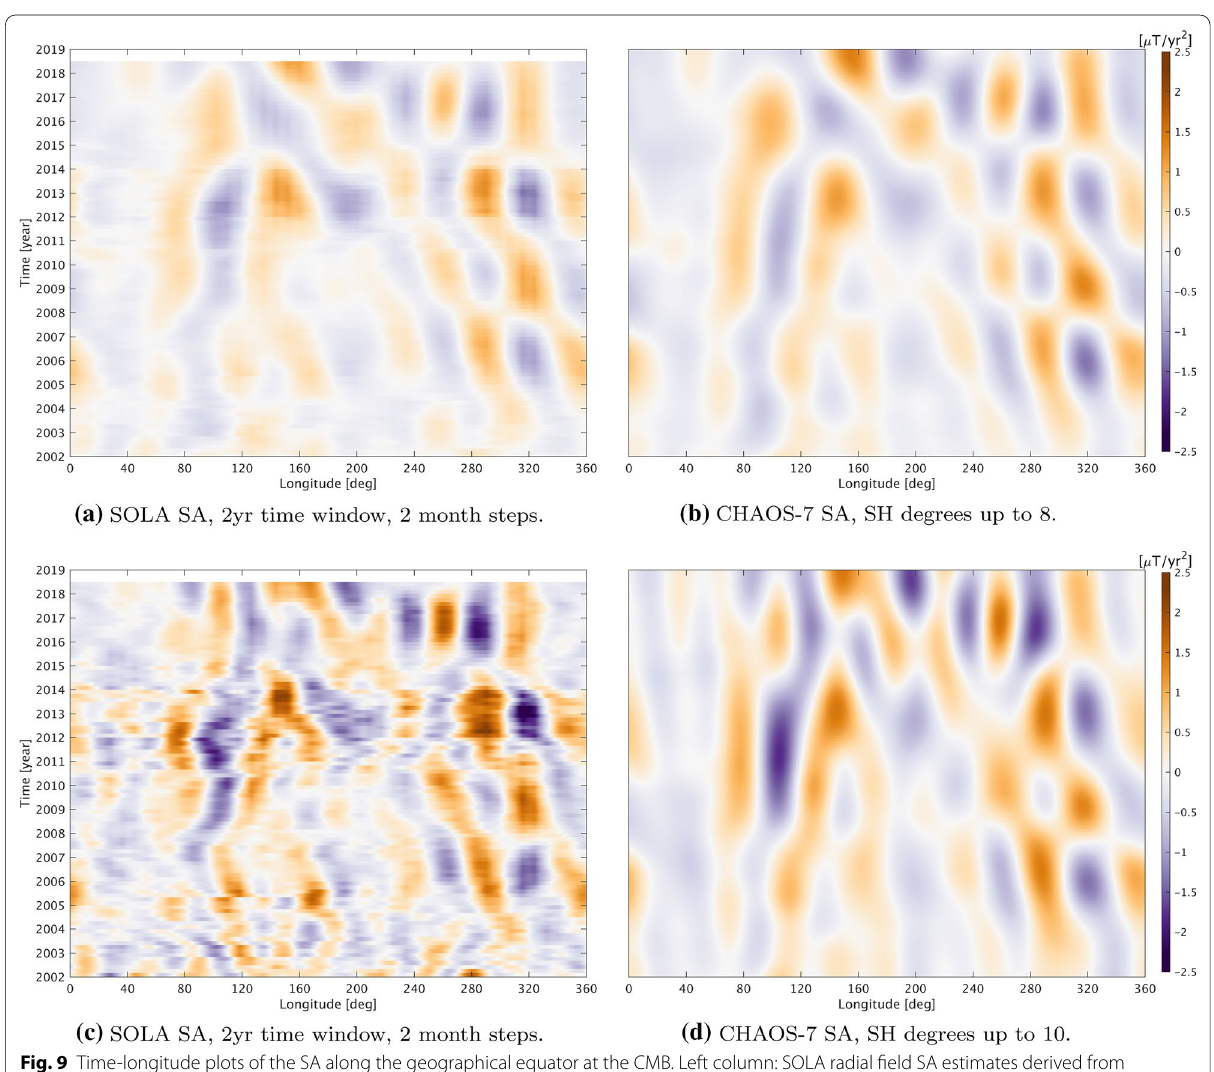
Fig. 9 Time-longitude plots of the SA along the geographical equator at the CMB. Left column: SOLA radial field SA estimates derived from differences between consecutive SOLA SV estimates based on 2-year data windows moving in 2-month steps and using (cid:31) = 3 × 10 − 2 nT − 1 (top left), and (cid:31) = 1 × 10 − 2 nT − 1 (bottom left). Right column: SA predictions from the CHAOS-7.2 model for SH degrees up to 8 (top right) and 10 (bottom right); note that temporal regularization causes significant time-averaging of the high-degree SA in the CHAOS